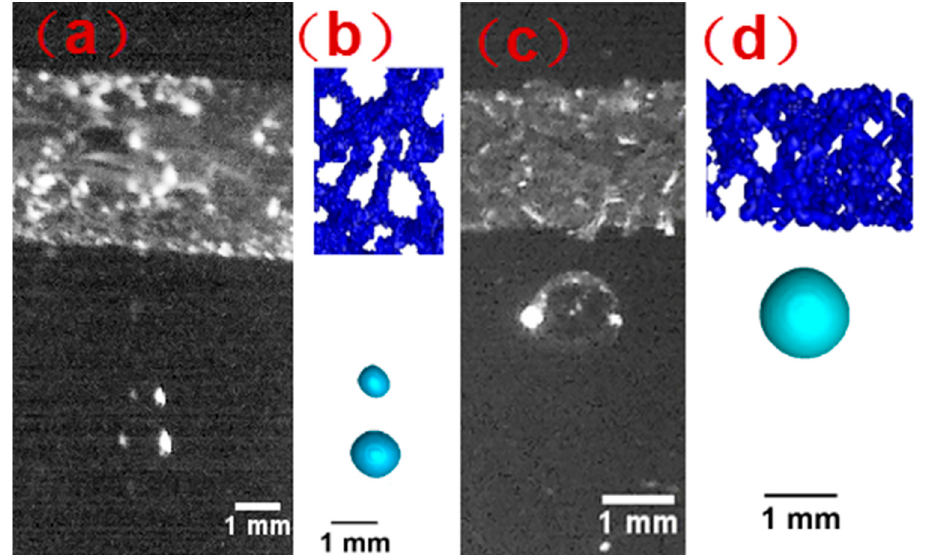
Figure 4. Comparison of the lattice Boltzmann method (LBM) simulation and the experimental results. ( a ) The experimental and ( b ) the simulation results for Ca = 0.063, D d = 1.06, and L d = 4.88. ( c ) The experimental and ( d ) the simulation results for Ca = 0.084, D d = 1.31, and L d = 2.44.